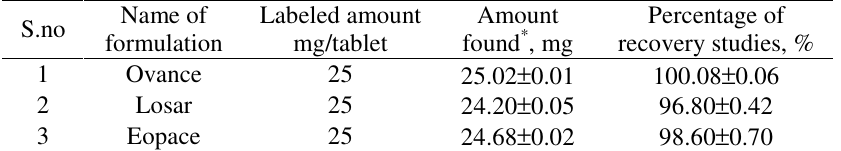
Table 2. Analysis of losartan potassium in recovery